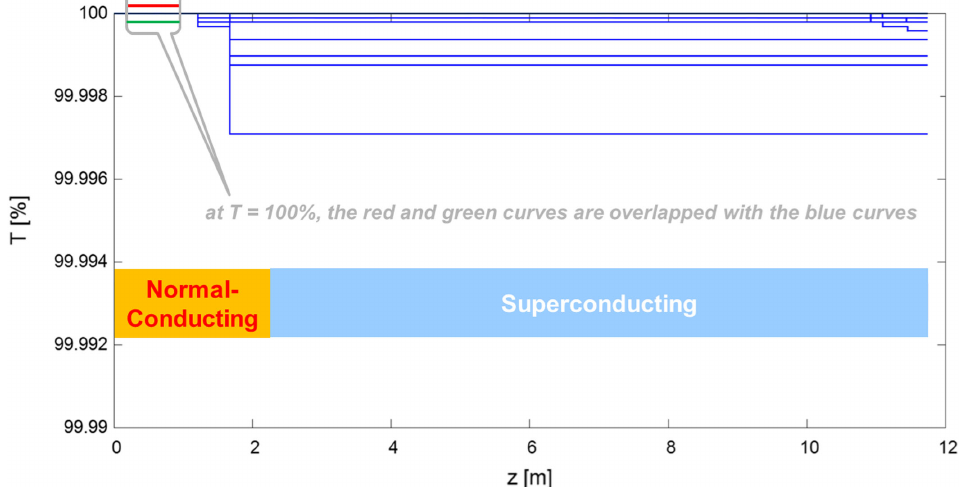
FIG. 15. Beam transmission efficiency evolutions for all runs with errors (red, batch 1; green, batch 2; blue, batch 3; because there is no beam loss for batch 1 and batch 2, only the blue curves can be